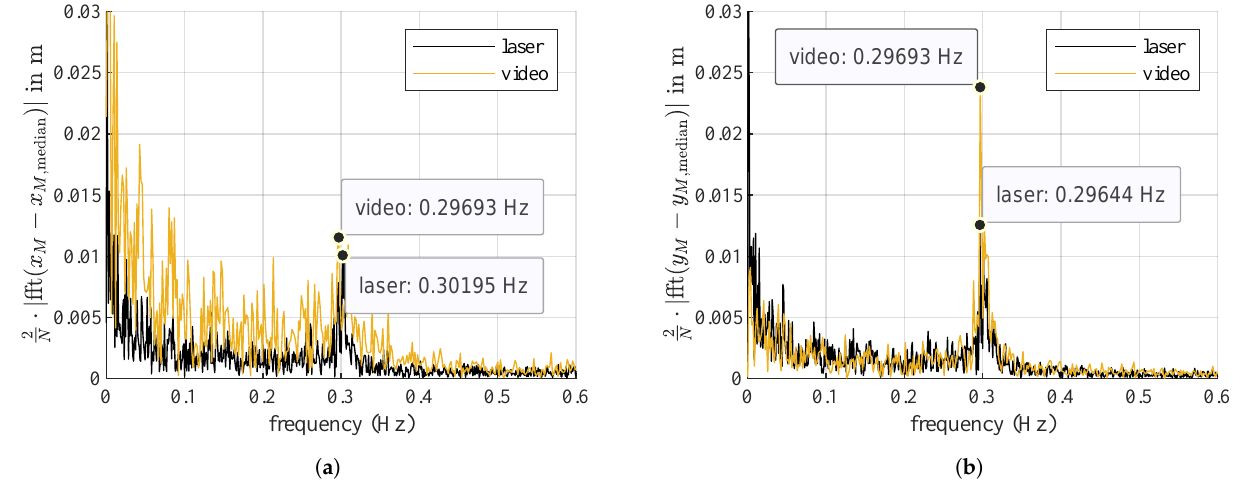
Figure 12. Tower movement in the lateral and axial direction. ( a ) Fourier transform of tower movement in the lateral direction ( x M ). ( b ) Fourier transform of tower movement in the axial direction ( y M